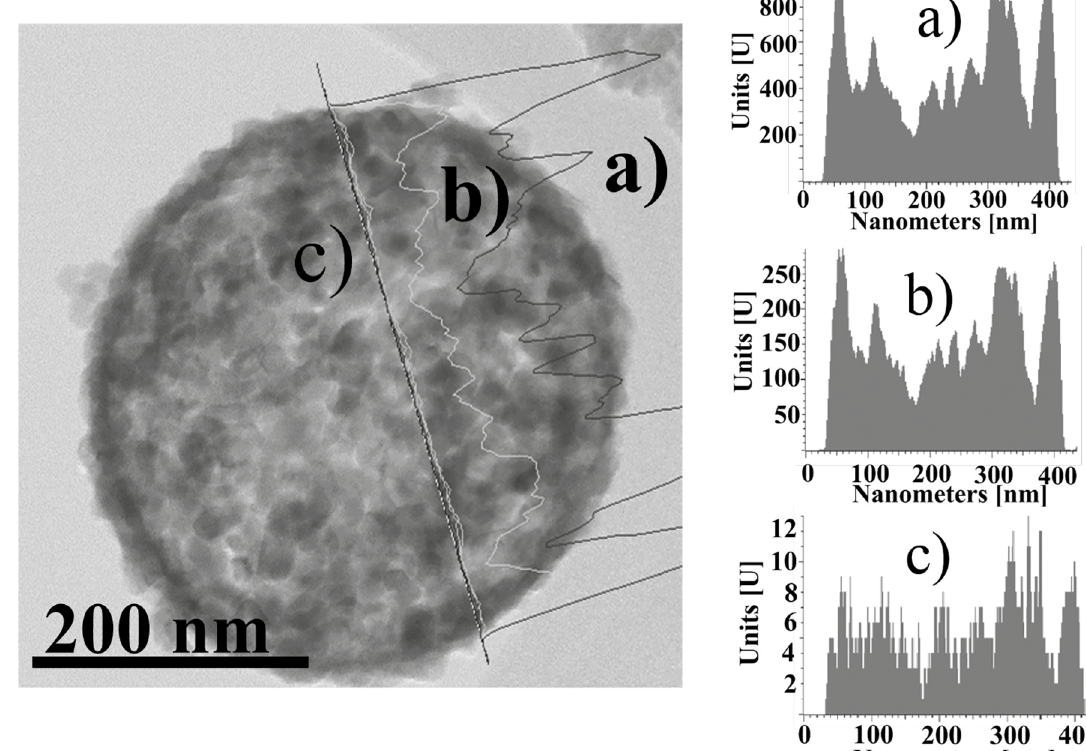
Figure 4: Scanning line by HRTEM, indicates the elemental distribution of As, O and Fe in MNPs.